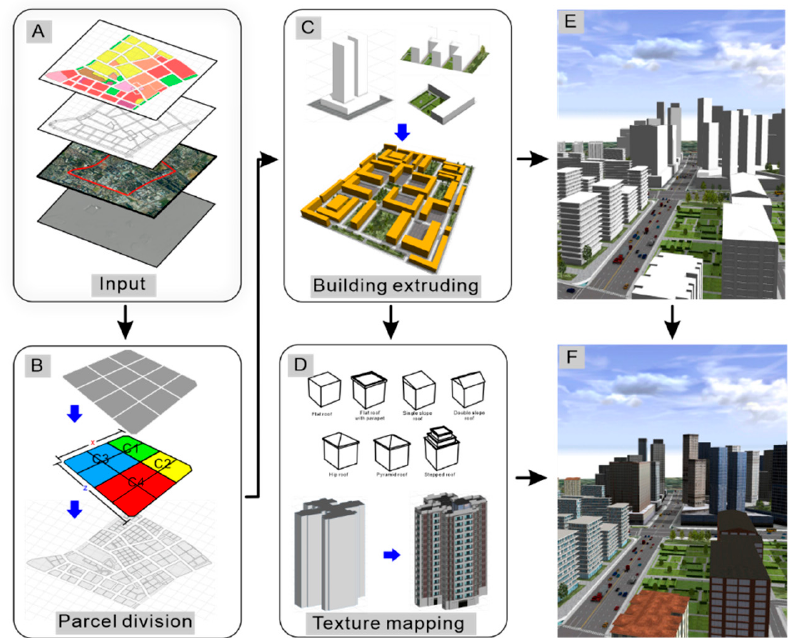
Figure 1. The workflow of semi-automated procedure modeling on urban scale, including parcel division, building extruding, and facade texture mapping process.